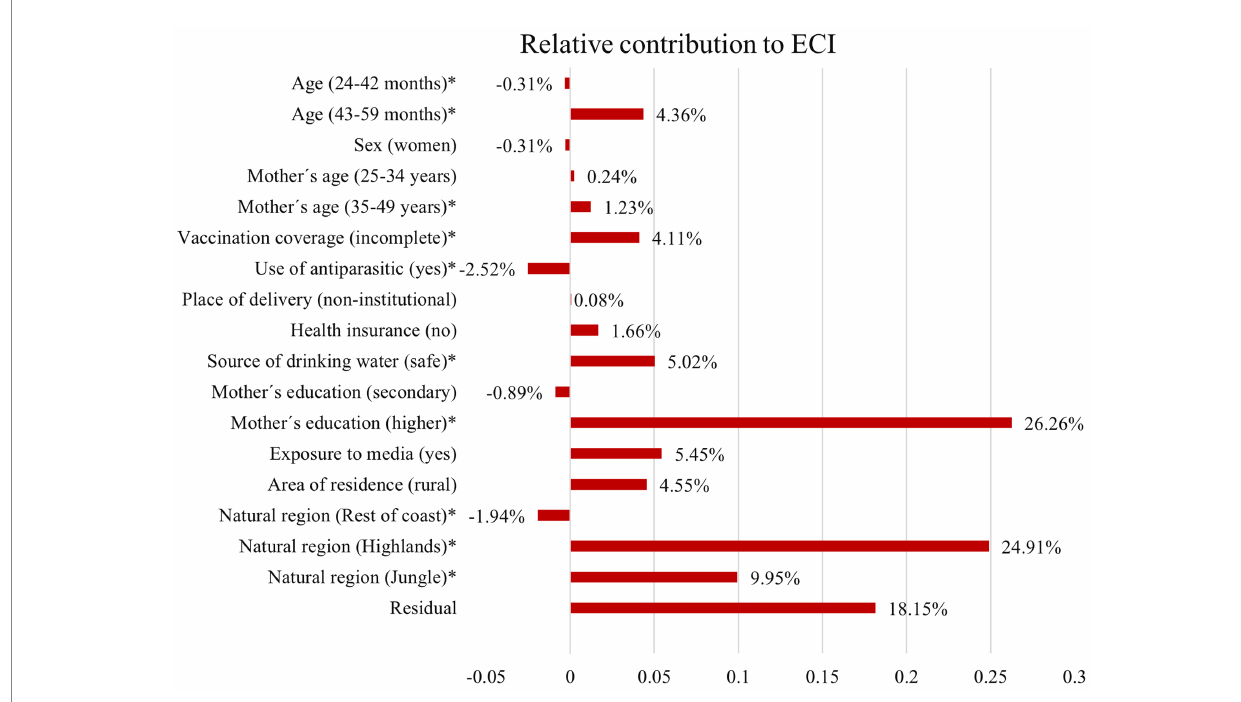
FIGURE 5 Decomposition of ECI: the relative contribution of each factor to inequality in anemia among Peruvian children. *indicates statistically significant ( p < 0.05) marginal effect derived from multivariable Probit regression